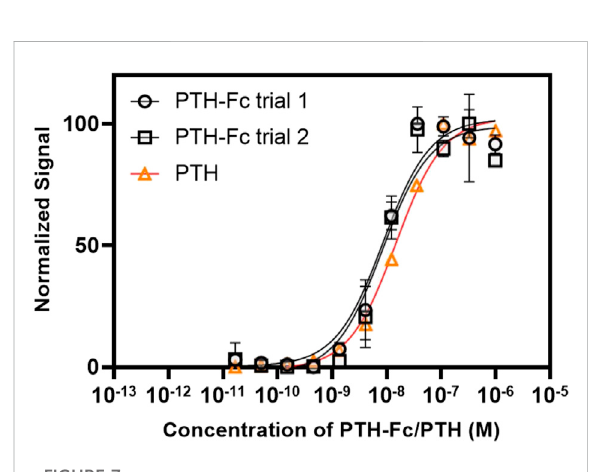
FIGURE 7 Dose-response curve from PTH-Fc or PTH treated CHO-K1 cells expressing